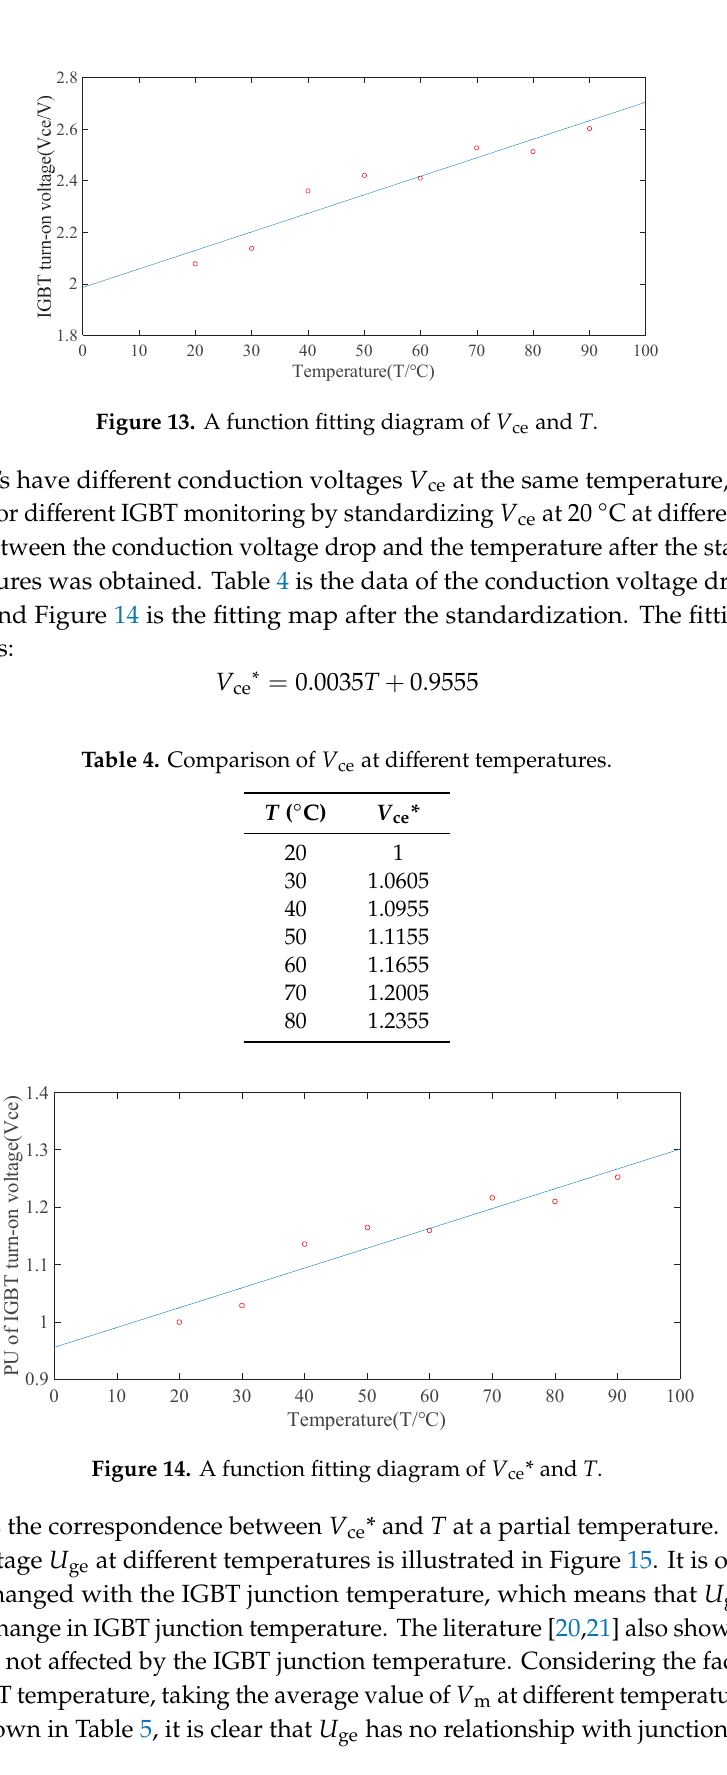
Figure 14. A function fitting diagram of V ce* and T. Table 4. Comparison of V ce at different temperatures.